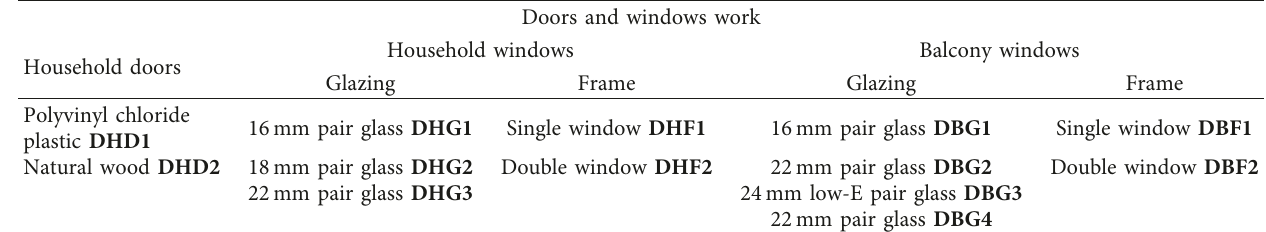
Table 7: Combination matrix (doors and windows